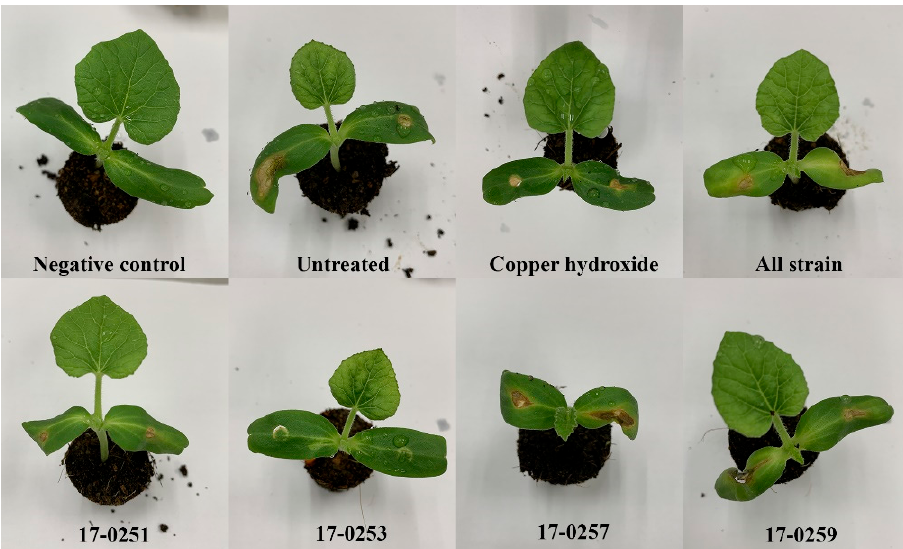
Figure 5. Effect of soil treatment of leaves of melon at seedling stage with cultures of endophytic fungi and copper hydroxide caused by Aac , JT-0003.